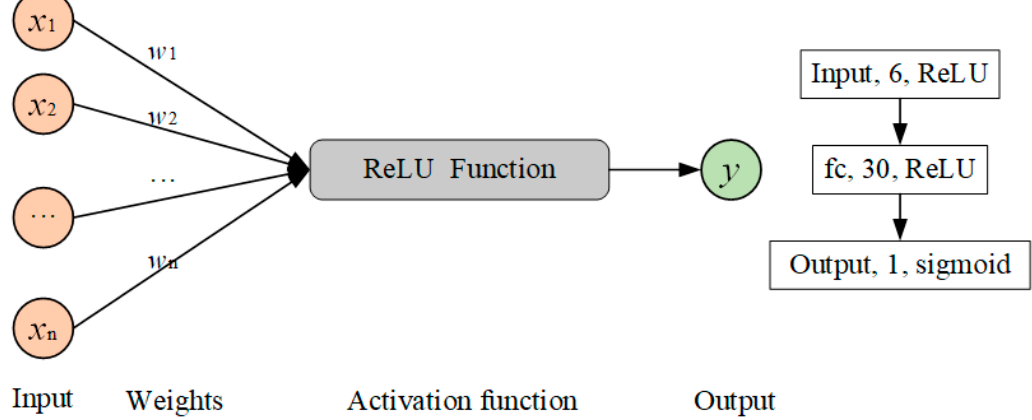
Figure 4. Schematic diagram of the discriminator structure.